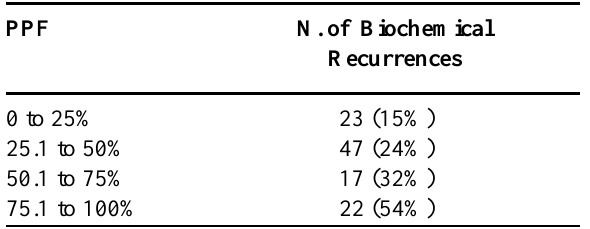
Table 5 – Relationship between the percentage of positive fragments (PPF) at pre-operative biopsy and the number of biochemical